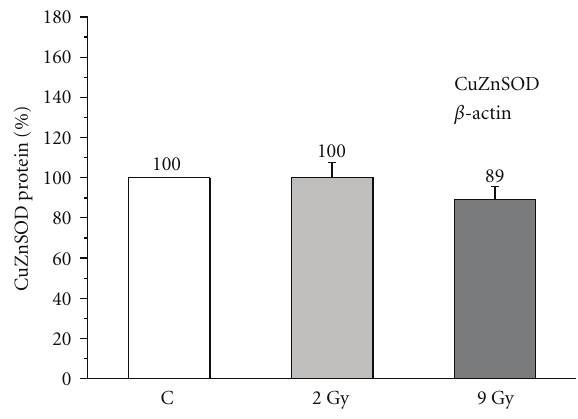
Figure 5: Relative level of CuZnSOD protein in blood cells nonir- radiated (C) and irradiated with 2Gy and 9 Gy of γ -radiation, in healthy women aged 45–58 years. Relative values are expressed as percent of value found in the nonirradiated control group, which is considered as 100% (student’s paired t -test).